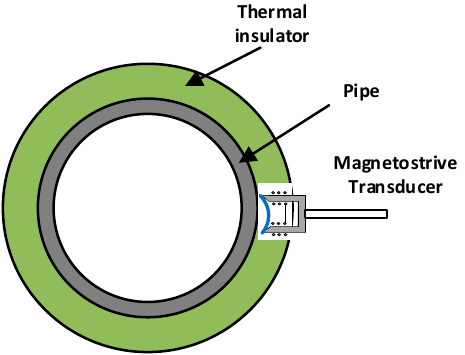
Figure 10. Positioning of the transducer.